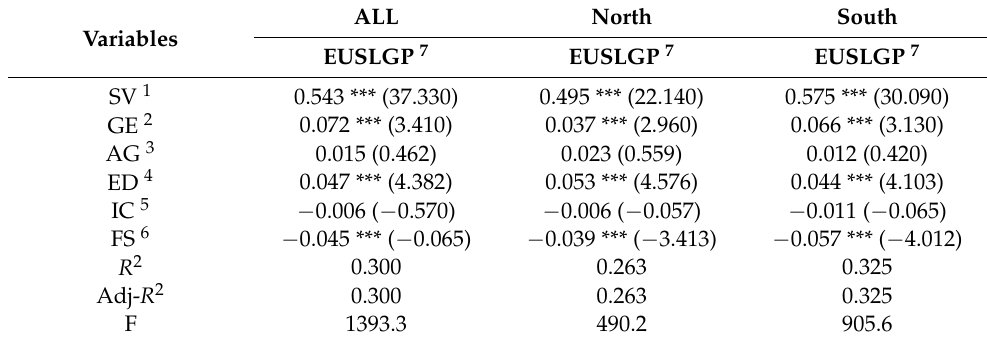
Table 2. Regression results of symbolic value and the EUSLGP .